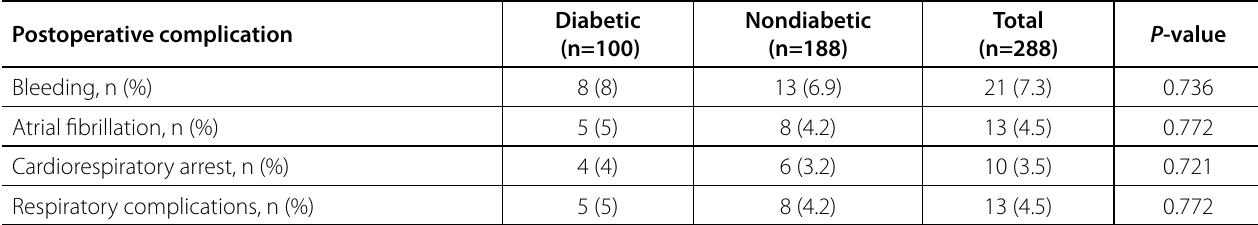
Table 4 . Comparison between diabetic and nondiabetic patients for the occurrence of postoperative complications. Postoperative